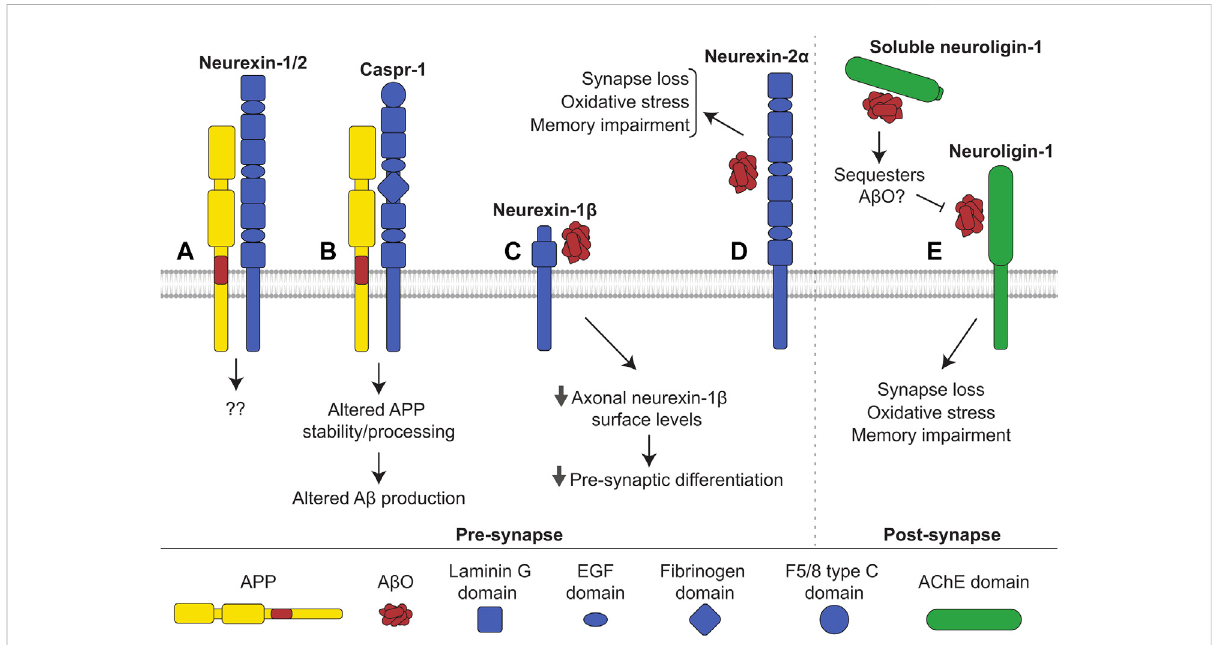
FIGURE 6 Interactions of neurexin and neuroligin with APP and A β . (A) Neurexin-1 and -2 interact with APP in mouse brains, with unknownconsequence. (B) Caspr-1 interacts with APP. This interaction alters stability and processing of APP in fl uencing production of A β . It is uncertain whether the interaction increases or decreases amyloidogenic processing. (C) A β Os bind to neurexin-1 β , reducing its levels at the axonal cell surface and hindering presynaptic differentiation. (D) A β Os additionally bind to neurexin-2 α triggering oxidative stress, synapse loss, and memory impairments in mice. Similarly, (E) A β Os interact with neuroligin-1 at the post-synapse, inducing oxidative stress, synapse loss, and memory impairmentsinmice.Sheddingreleasessolubleneuroligin-1whichalsobindstoandlikelysequestersA β Os,preventinginteractionswithmembrane- bound neuroligin-1 and other